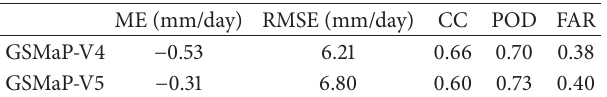
Table 2: Validation statistics comparing the performances of GSMaP rainfall estimates over the Chinese Mainland from 2003 to